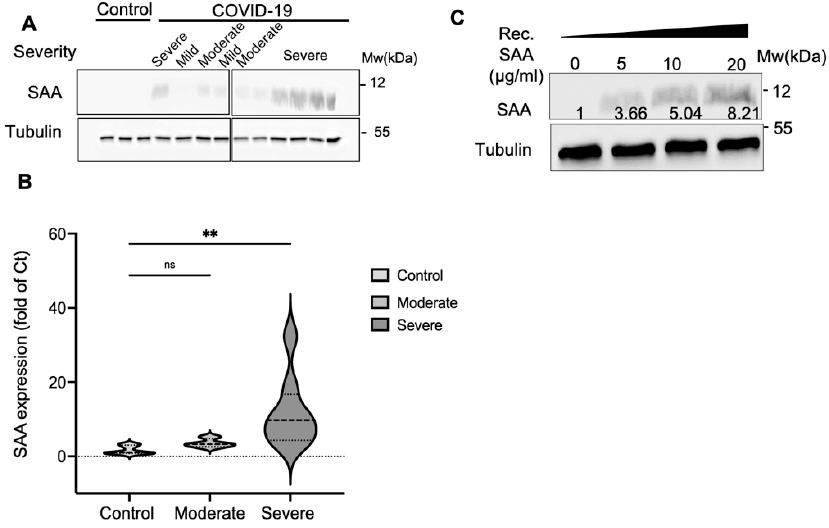
Figure 2. Serum SAA from COVID-19 patients binds healthy platelets in a dose-dependent manner. ( A ) Platelets from a healthy donor were incubated with serum from controls ( n = 3) or different COVID-19 patients with varying disease severity ( n = 10). Following incubation, the platelets were washed and lysed. SAA levels were measured by western blot. SAA was detected using a specific antibody. Tubulin was used as a loading control. ( B ) Densitometric quantification of a series of experiments performed as described in A. The results are from six independent repeats. One-way ANOVA, ns = non-significant, ** p < 0.01. ( C ) Platelets from a healthy donor were incubated with varying amounts of recombinant SAA for 1 h at 37 °C. The platelet protein lysates were separated using SDS-PAGE. Numbers indicate densitometric analyses of the band intensity compared to tubulin expressed as folds of the non-treated control. Shown is a representative experiment from at least three independent repeats.